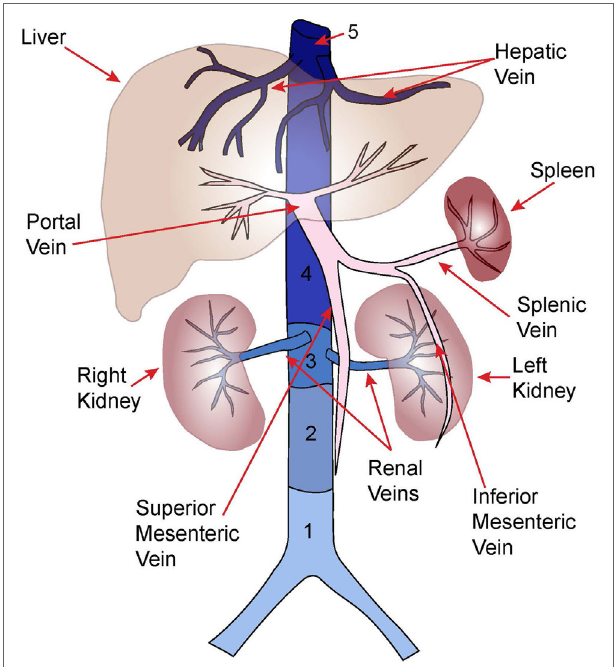
FigURe 1 | Anatomy of major abdominal veins. Inferior vena cava segments adapted from Ref.